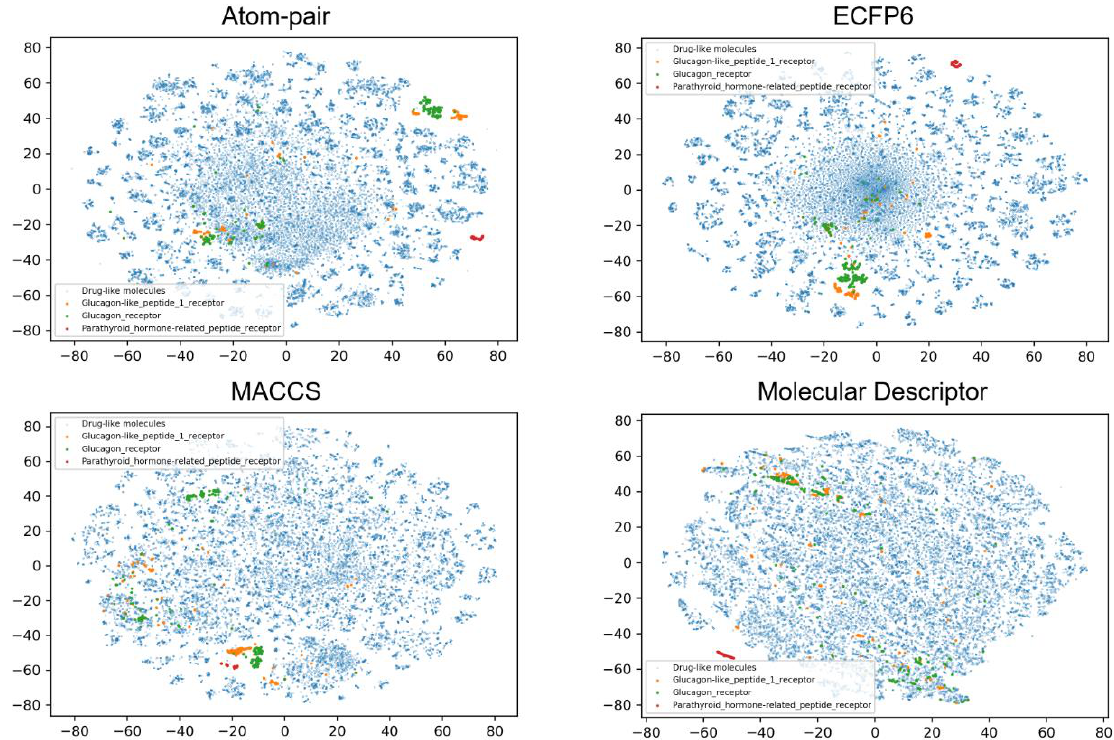
Figure 3. t-SNE method was used to visualize the chemical distribution of allosteric modulators from three subtypes of class B GPCRs according to Atom-pair, ECFP6, MACCS fingerprints, and molecular descriptors.